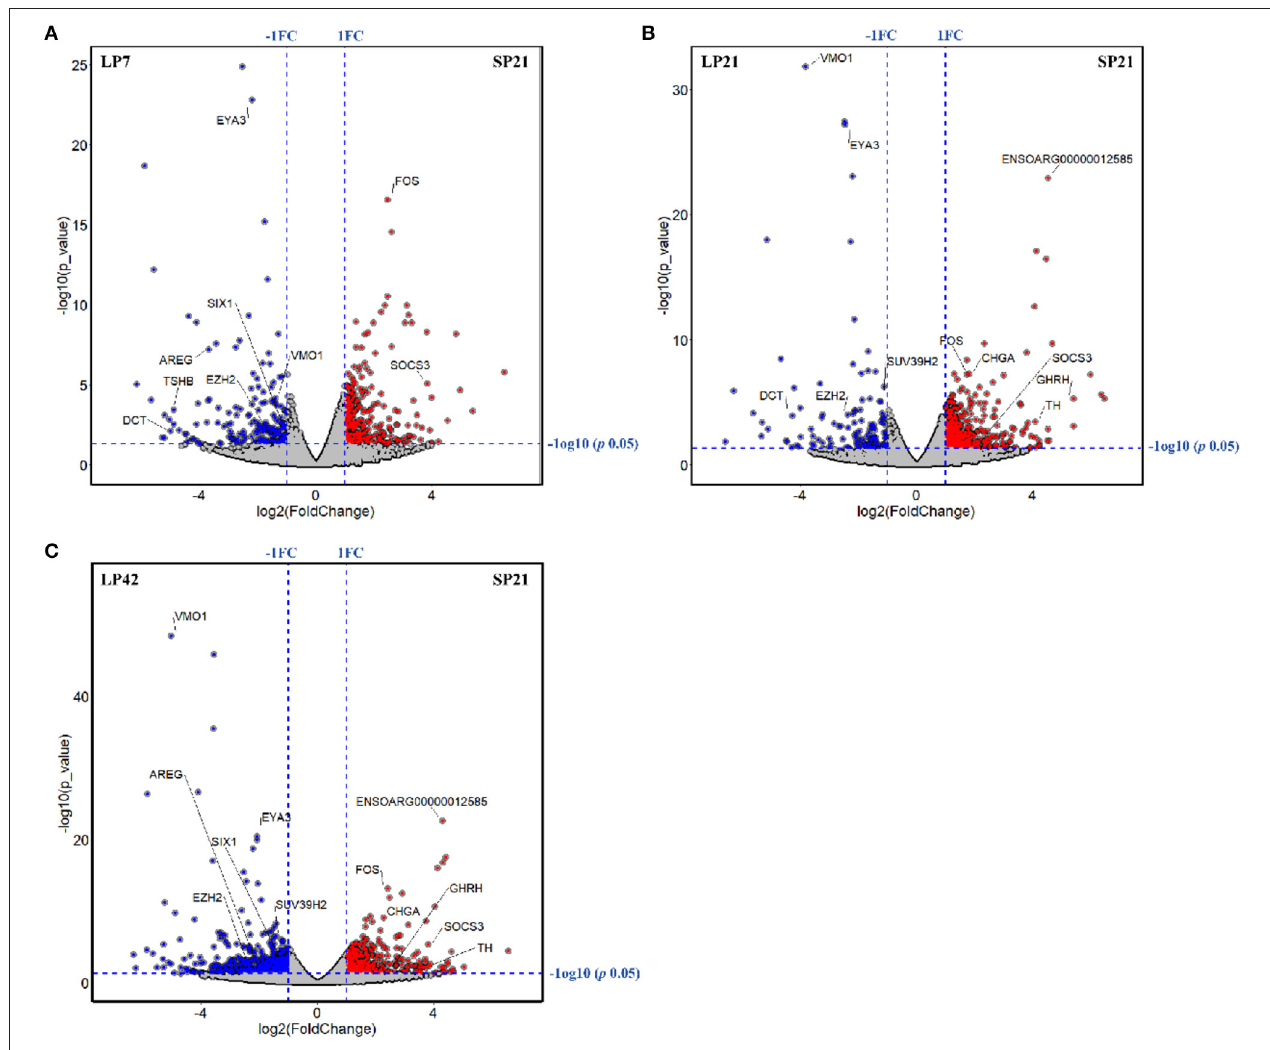
FIGURE 3 | The volcano plots of differentially expressed genes between long photoperiod (LP) and short photoperiod (SP) in PT of Sunite sheep. (A) The results of LP7 vs. SP21; (B) the results of LP21 vs. SP21; (C) the results of LP42 vs.